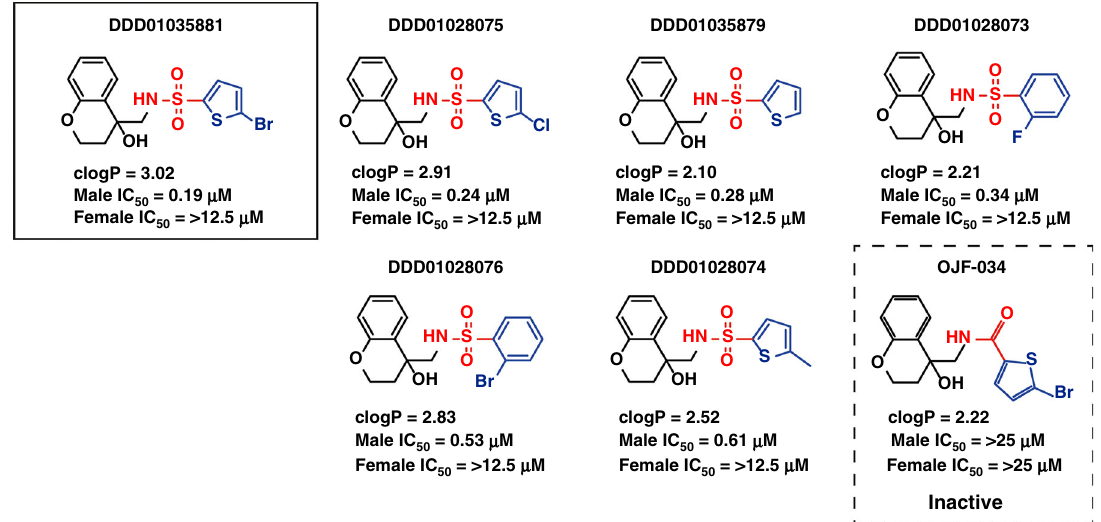
Fig. 7 Pf DGFA structure activity relationship between DDD01035881 and analogues. Red and blue groups indicate modi fi cations to respective parts of the parent molecule. Analogue IDs correspond to molecules within the GHCDL with the exception of OJF-034 which was synthetised in-house